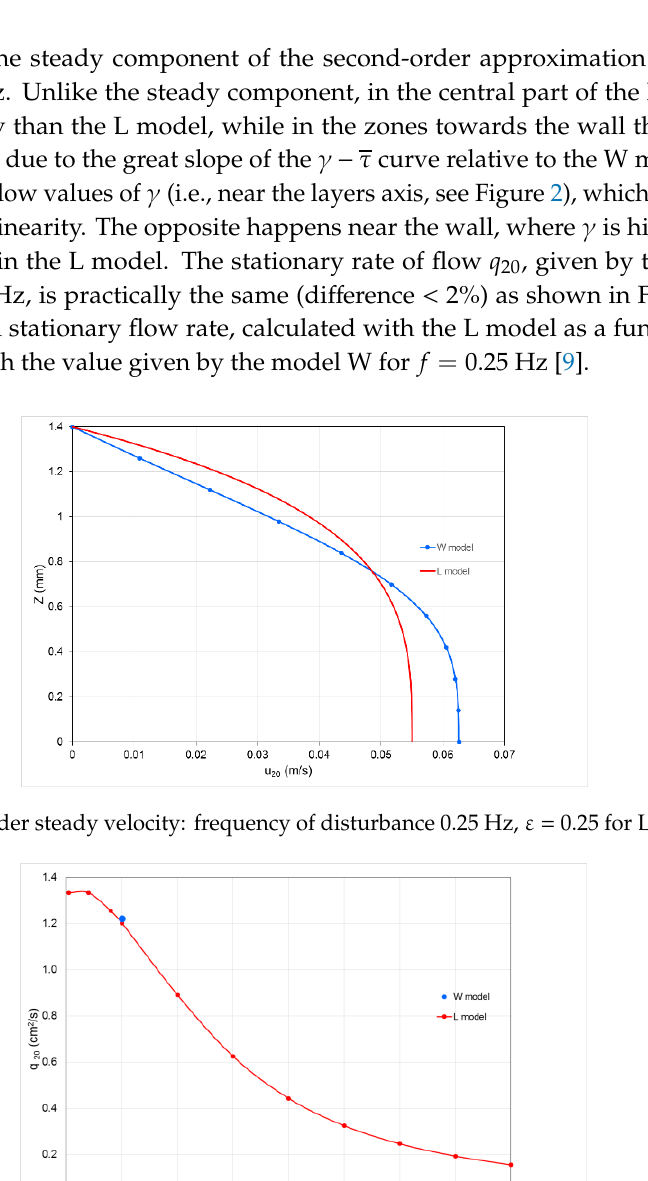
Figure 6. Discharge as a function of the frequency for the L model; the dot shows the value of discharge for the W model for f = 0.25 Hz [9].